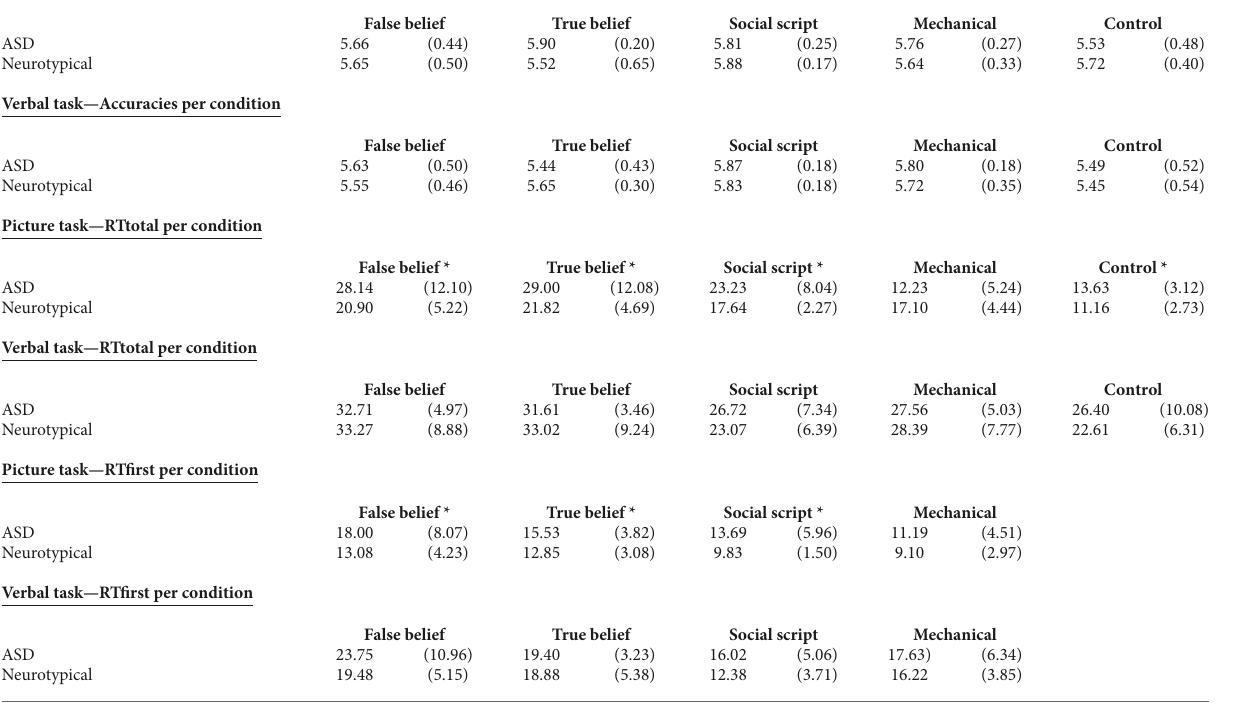
TABLE 1 Mean accuracies and response times per task, group, and sequence